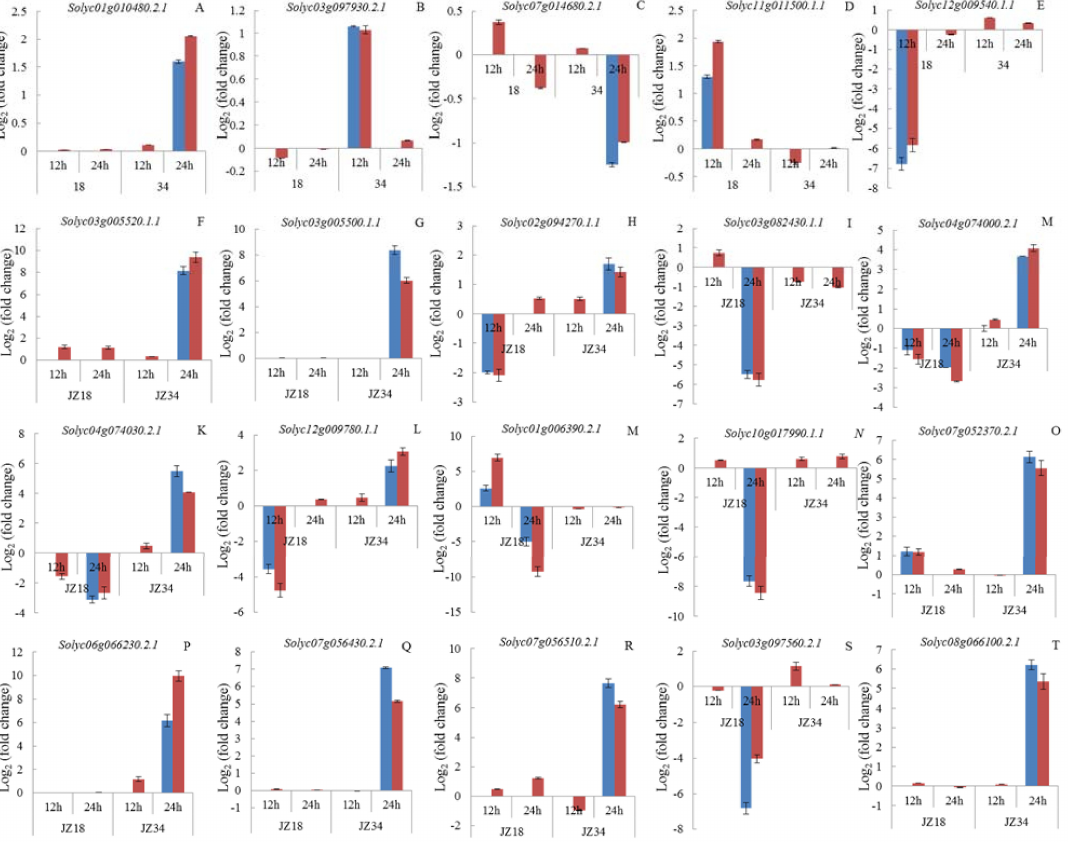
Figure 3. Quantitative real-time PCR validation of 20 differentially expressed genes (DEGs). The blue column represents RNA-seq data, and the red column represents real-time PCR data. The experiments were repeated three times. The genes ( A – T ) function annotations are shown Table S1.Gene-specific primers used for real-time PCR are listed in Table